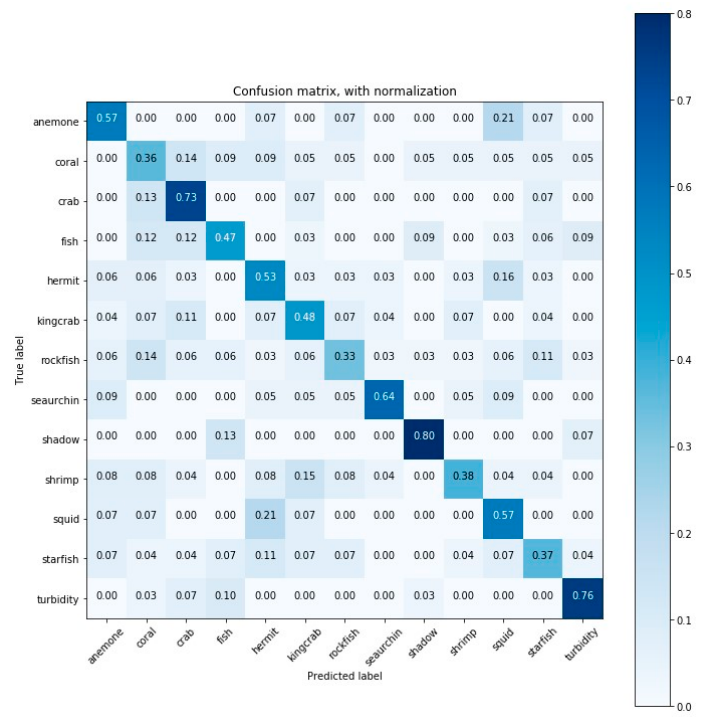
Figure A6. Confusion matrix for the classification results (accuracy) obtained by DT-2.